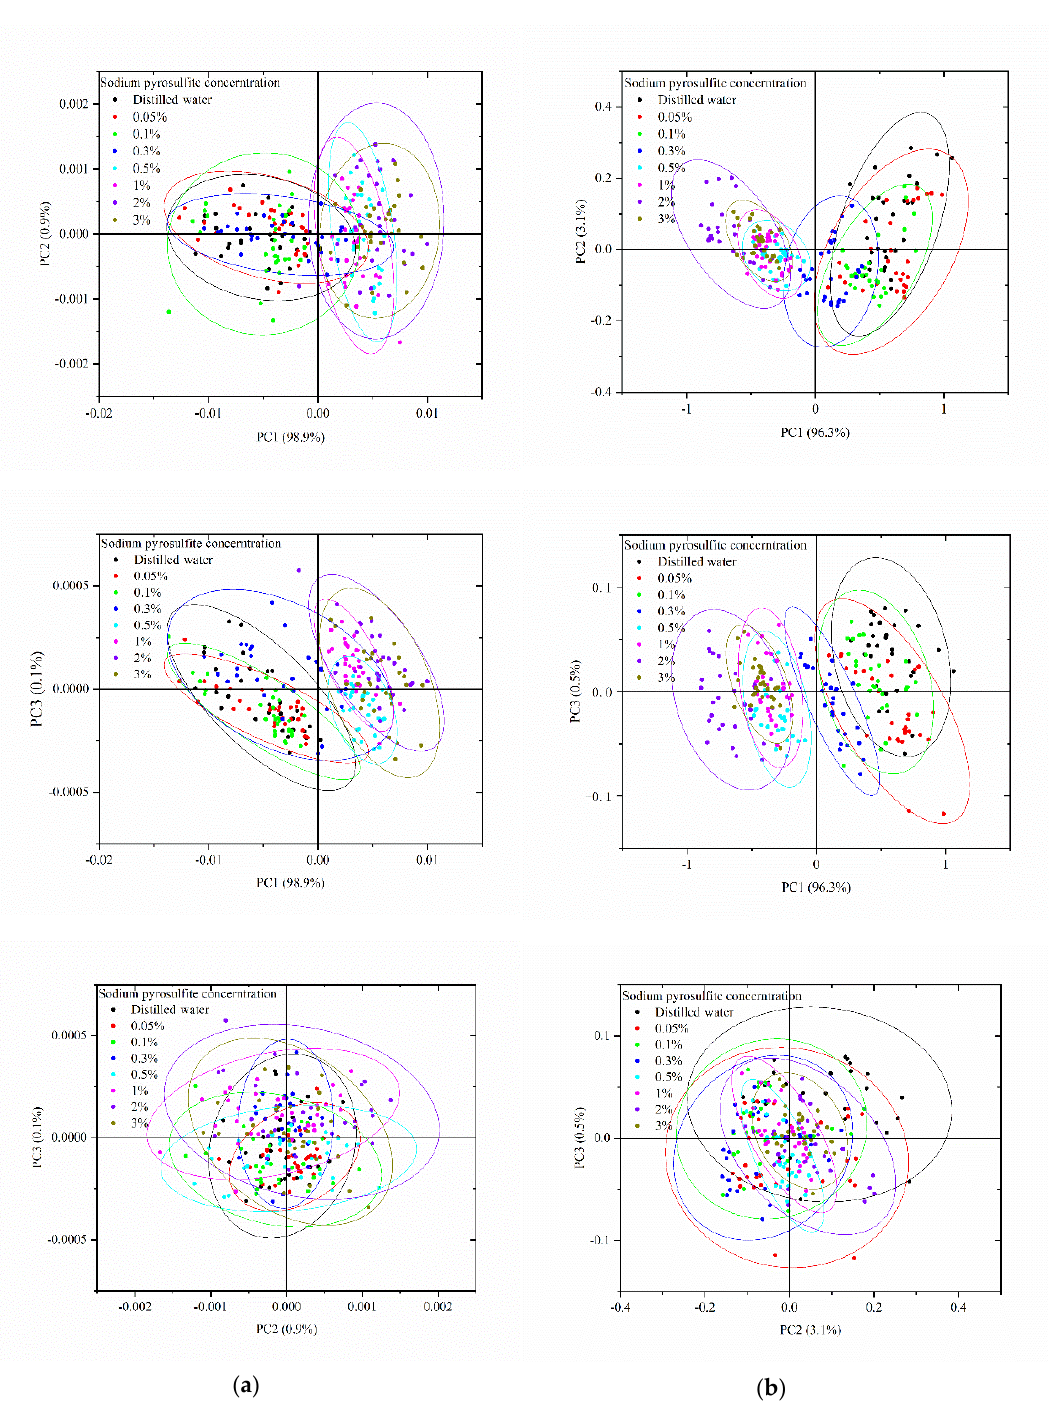
Figure 2. Principal component analysis (PCA) scores scatter plots of the first three principal components (PCs): ( a ) portable NIR spectrometer and ( b ) NIR-HSI system. (PCs): ( a ) portable NIR spectrometer and ( b ) NIR-HSI